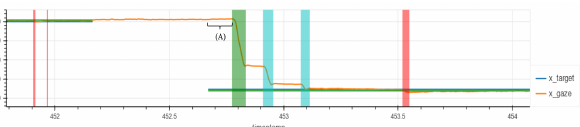
Figure 1. Horizontal saccade task on an eye tracking device op- erating at 200 Hz. The red bars identify microsaccade events. The vertical green bar highlights a saccade toward the target with blue bars identifying corrective saccades. (A) represents saccade la- tency (reaction time from stimulus presentation to initiation of saccade). The blue and green horizontal lines represent the target location while the orange line represents the healthy participant’s gaze trajectory. X-axis represents time in seconds while the Y- axis represents distance in pixels. Original data acquired using a 200 Hz eye tracking device on a healthy 42-year-old male volun-